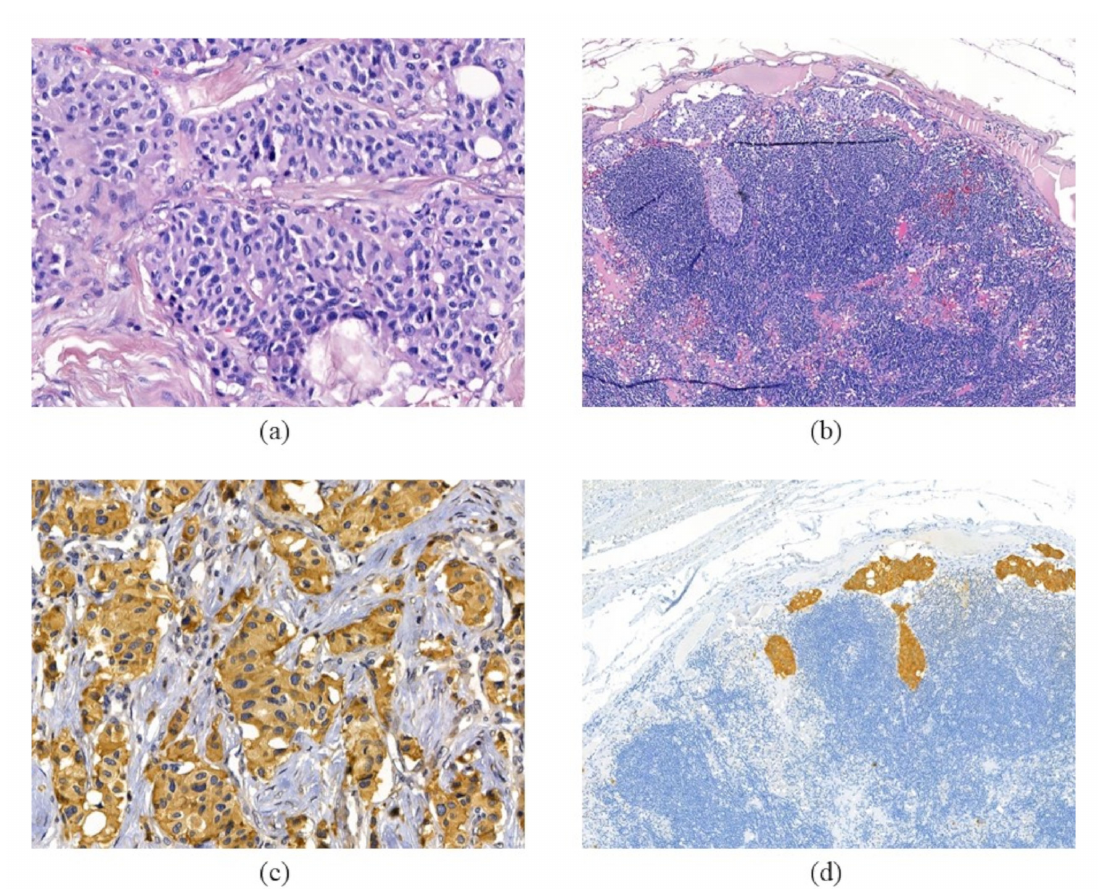
Figure 1. Histologic and immunohistochemical sections of recurrent tumor and metastasis. Hematoxylin–eosin staining of the tumor ( a ) and lymph node ( b ) tissues displays a specific “Zellballen” growth pattern. Chromogranin A antibodies stain chief cells in the tumor ( c ) and metastasis ( d ).400 × magnification for ( a ) and ( c ) and 100 × magnification for ( b ) and ( d ).